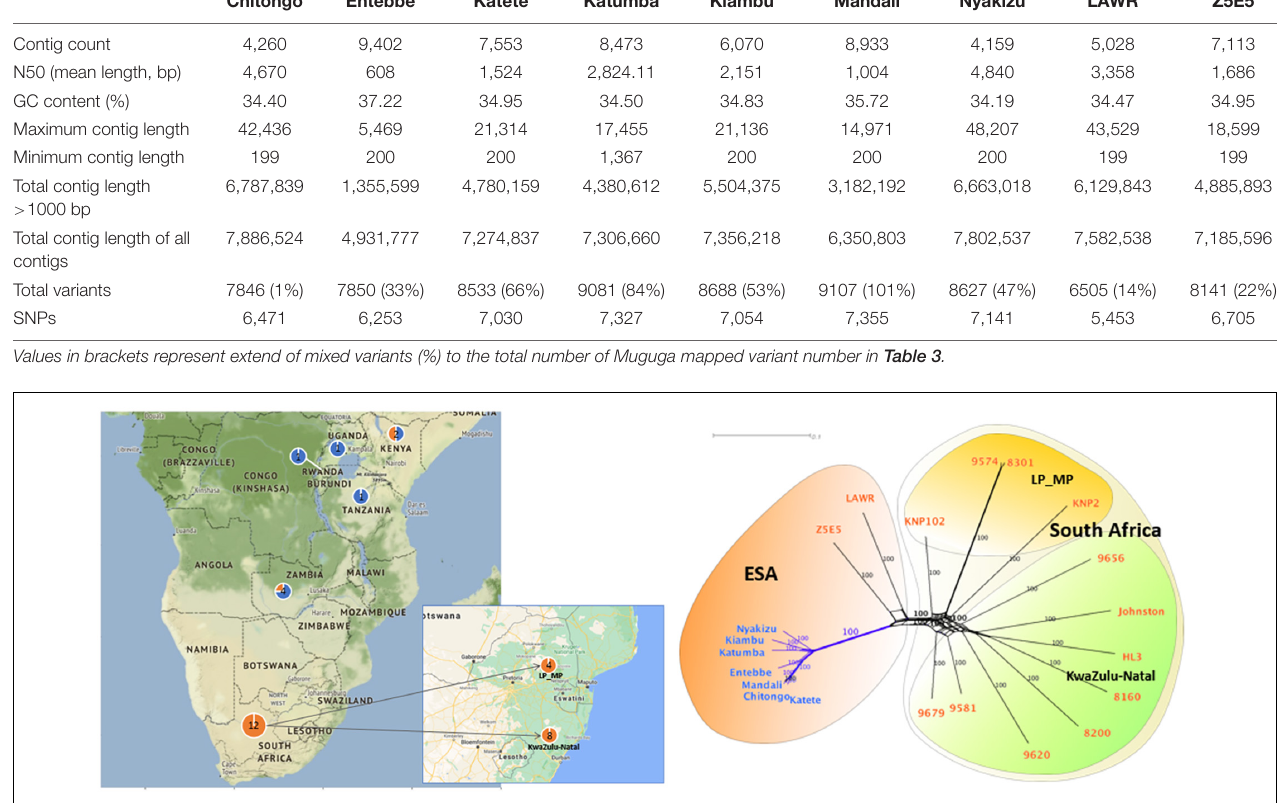
FIGURE 2 | SNP phylogenetic and geographical relationships of T. parva strains across selected South and East African countries. Blue font represents cattle-derived strains. Orange font represents buffalo-derived strains. LP stands for Limpopo. MP stands for Mpumalanga. ESA stands for eastern and southern Africa. The phylogenetic tree was calculated by maximum likelihood analysis using PAUP*. Nodal support was assessed with 1000 bootstrap replicates. Number of nucleotide substitutions estimated at 0.01. 9574, 9656, Johnston, 8200 and 9620 were collected from a cattle